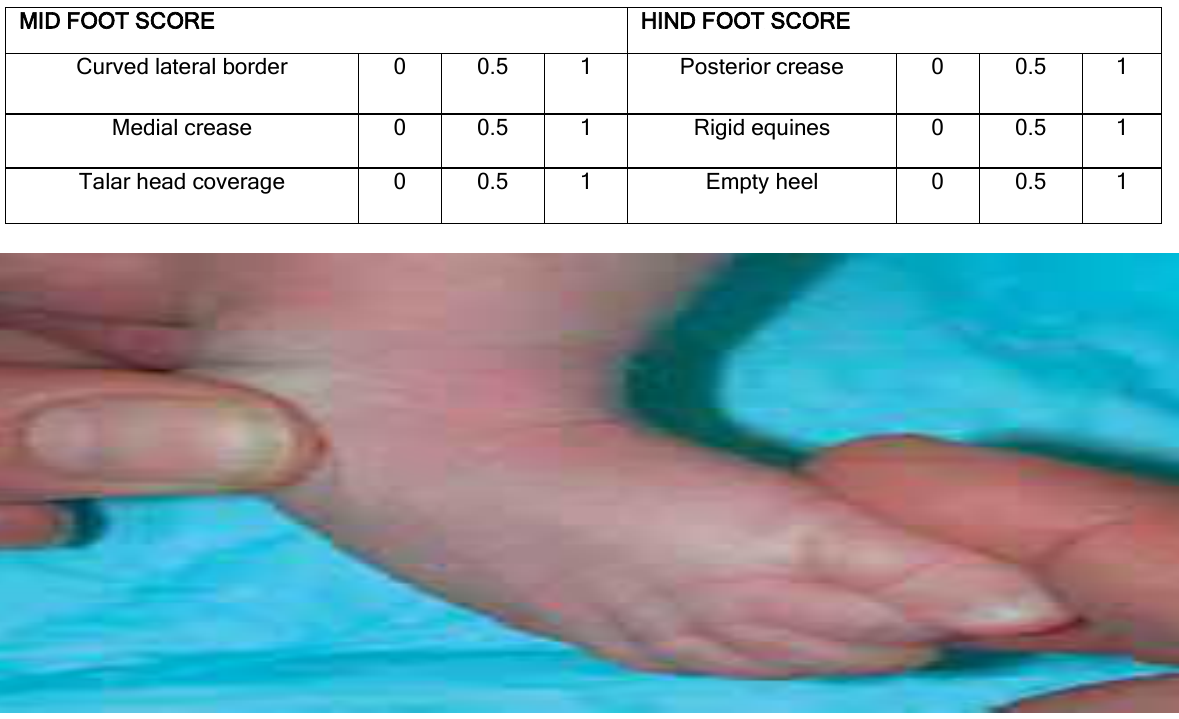
Figure (1): Localization the head of